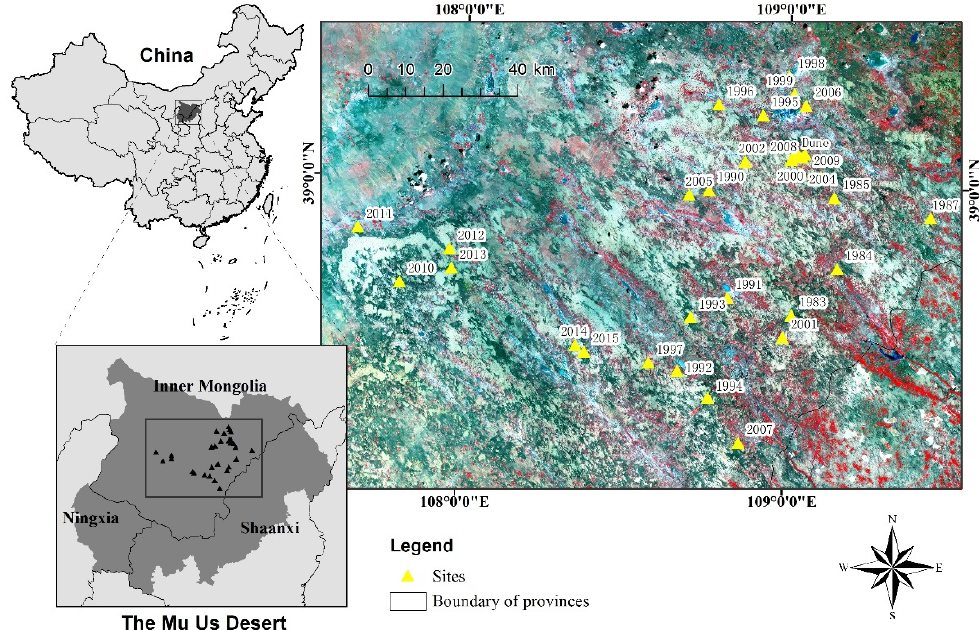
Figure 1. Study area of the Mu Us Desert, China, and 32 investigated field sites from 1983 to 2015. The black and yellow triangle represent the field sites.